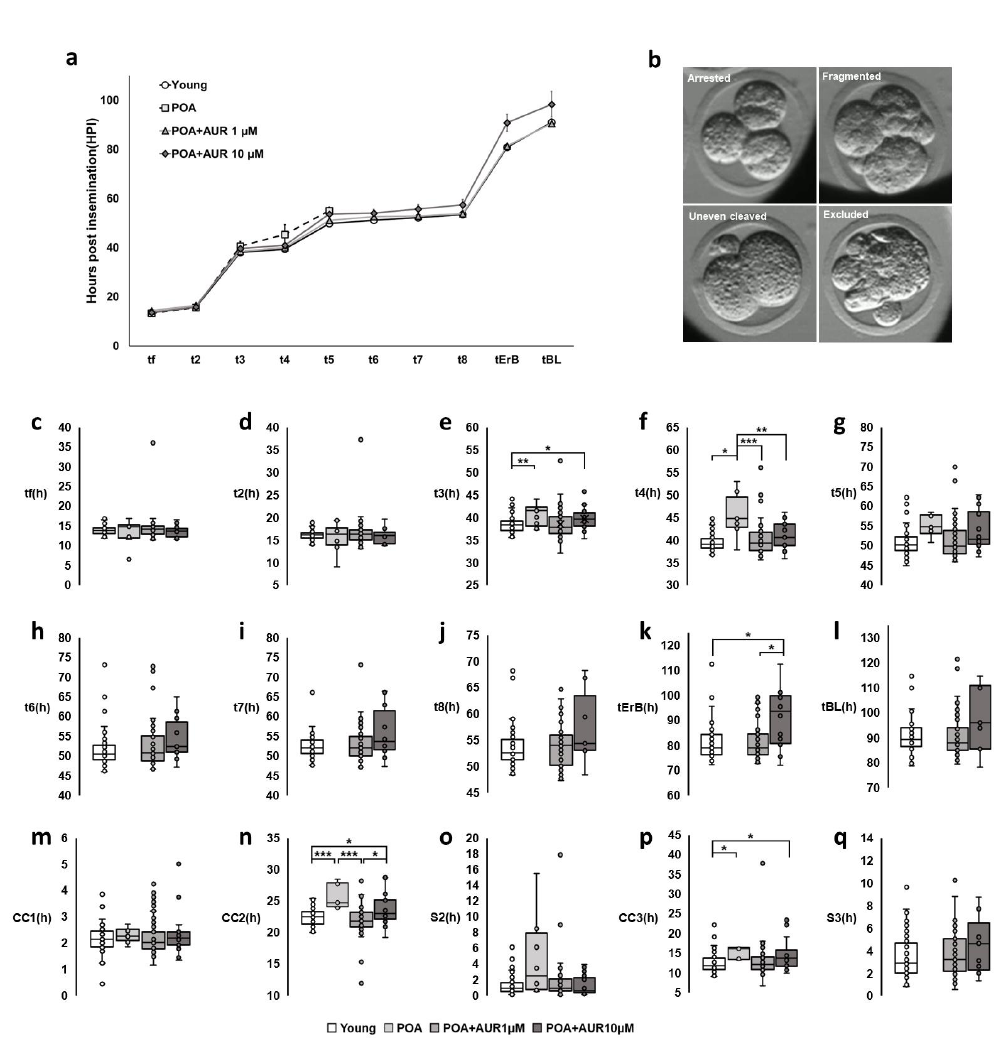
Figure 7. AUR advanced the morphokinetics of embryos from postovulatory aged oocytes. ( a ) Com- parison of the morphokinetics of embryos derived from oocytes of the Young, POA, POA+AUR 1 μM and POA+AUR 10 μM groups. ( b ) Representative images of embryos from aged oocytes that had not reached the blastocyst stage. ( c – q ) t2, t3, t4, t5, t6, t7, and t8: time in hours post insemination (HPI) required for embryos to reach the 2-, 3-, 4-, 5-, 6-, 7-, and 8-cell stage, respectively; tErB: time to start formation of blastocoel cavity; tBL: half or more of blastocoel cavity had formed; CC: length of the cell cycle; S: synchronicity or round of cleavage division. Dots of boxplot show individual values of each observation. Data are presented as the means ± SEMs of at least three independent experiments, * p < 0.05, ** p < 0.01, *** p < 0.001.